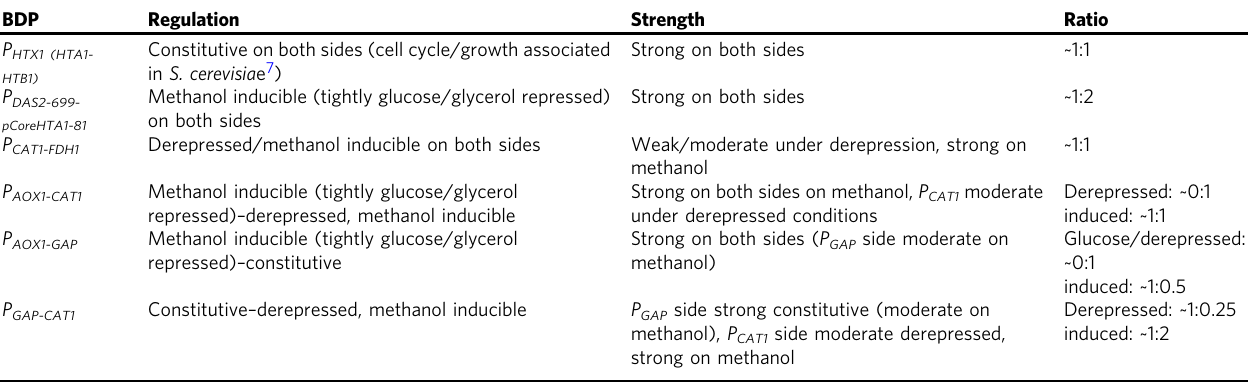
Table 1 Minimal set of diverse BDPs covering broad regulatory pro fi les for co-expression